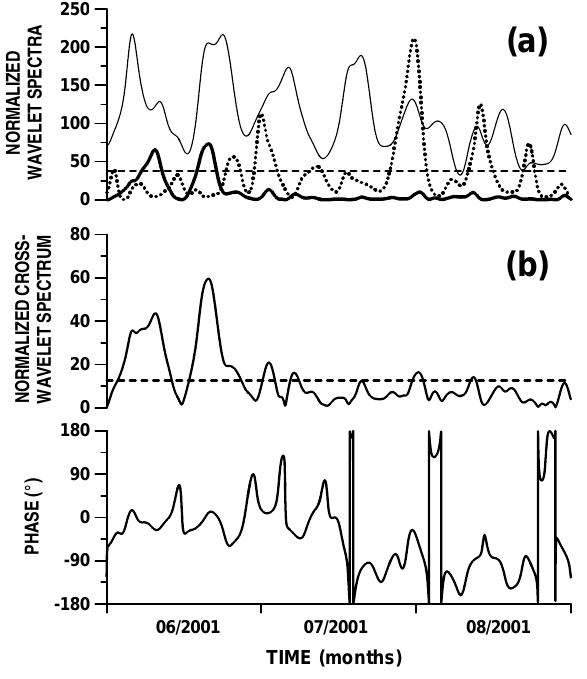
Fig. 7. (a) Wavelet spectra of thermocline displacement at Cape Struga (thick full line), sea level at Dubrovnik (thin full line) and NE wind component at Dubrovnik (dotted line), for the interval between June and August 2001, at the K1 tidal frequency. (b) Corresponding cross-wavelet spectrum of the sea level at Dubrovnik and thermocline displacement at Cape Struga. The spectra are normalized by the respective variances. Dashed lines denote 95% significance levels.